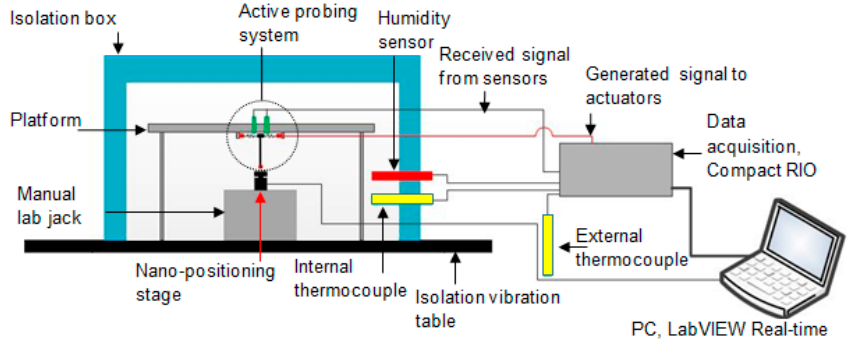
Figure 6. Schema of the setup for characterisation of the micro-probing system in z direction.